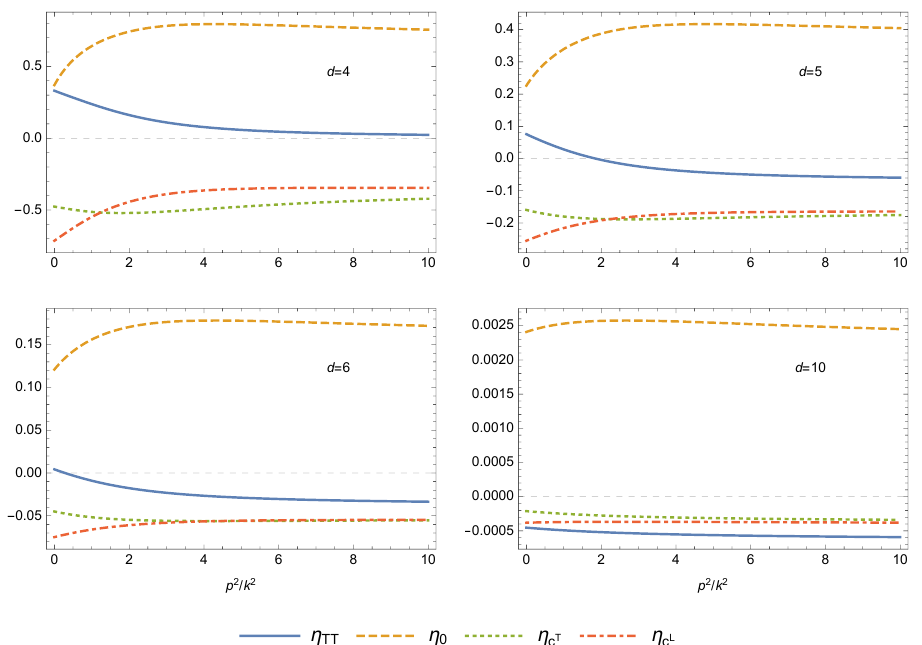
Figure 3. Dimensional dependence of anomalous dimensions for the choices g = 1, µ TL = 0, µ 0 = 0, − 1 and the regulator (83). For clarity, we have reinstated k in the momentum argument. β h = d 2 There are three contributions to the flow of the spin two two-point function: the graviton tadpole, the graviton self-energy, and the ghost self-energy diagram, see Figure